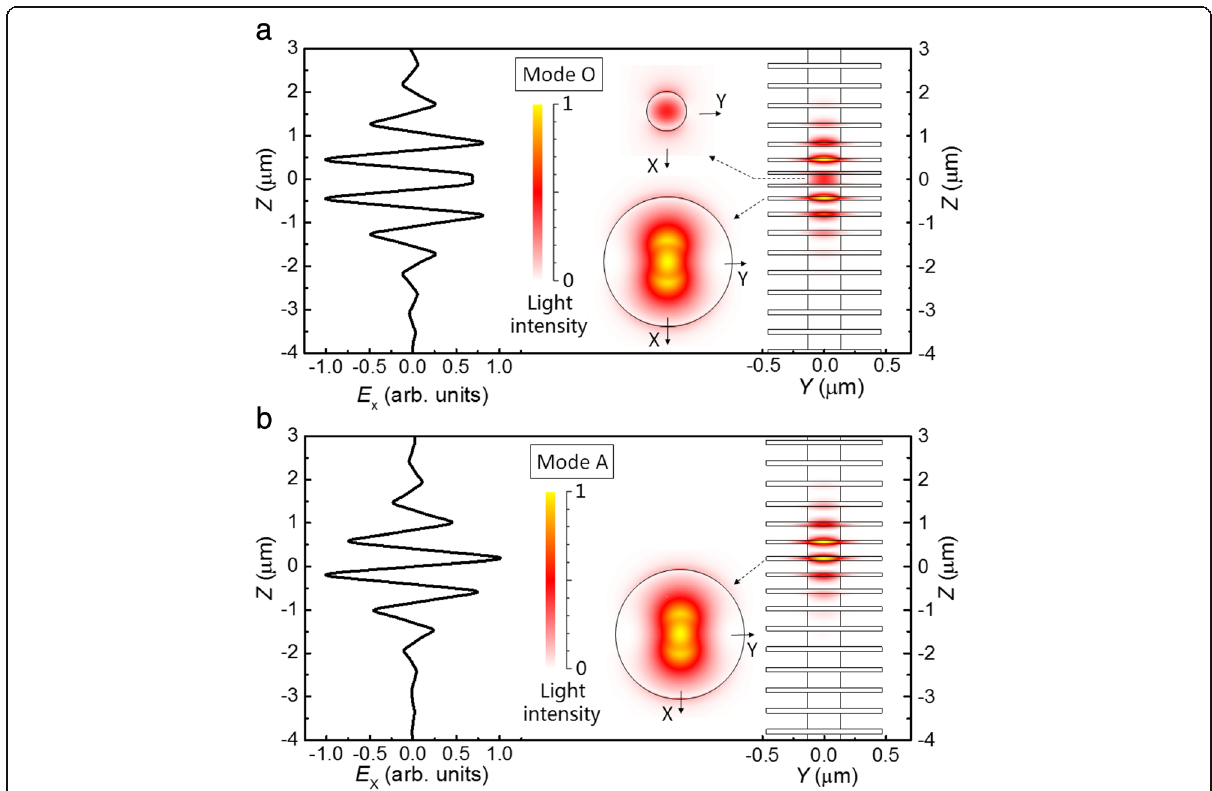
Fig. 2 Line mode profiles along vertical Z direction and patterned mode profiles on the YZ and XY planes of the optimized optical a mode O and b mode A. Note that the line profiles are indicated by the X-polarized electric field, while the plane profiles are displayed by light intensity. The thin lines on the light intensity patterns show the outlines of the optimized